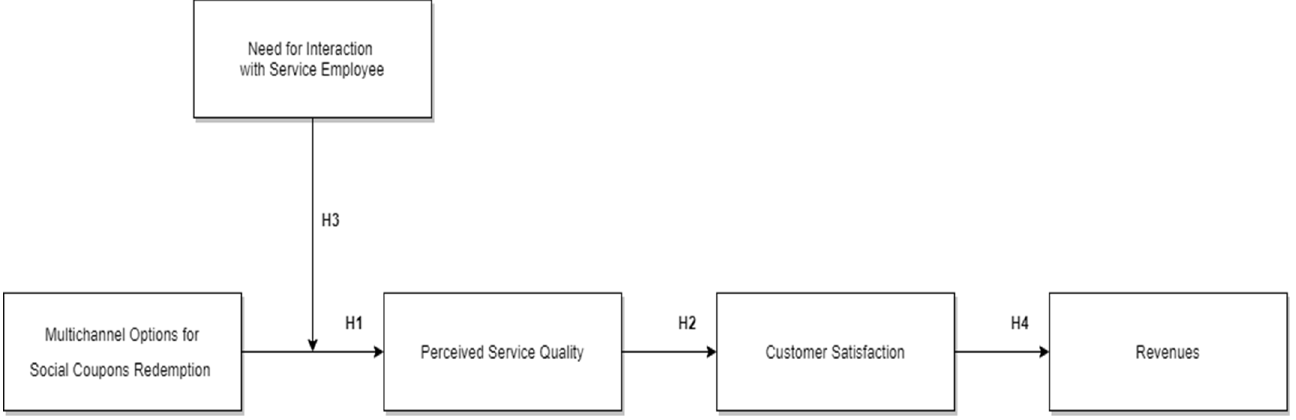
Figure 1. Conceptual